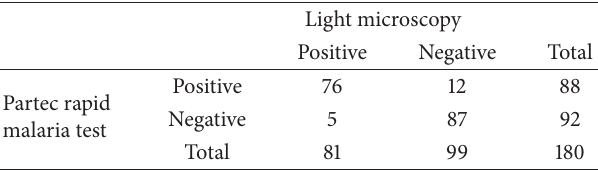
Table 2: Results of light microscopy and Partec rapid malaria